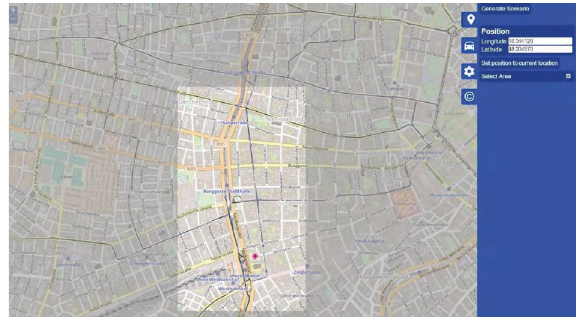
Figure 1: Definition of the area from Open Street Map used in the experimental